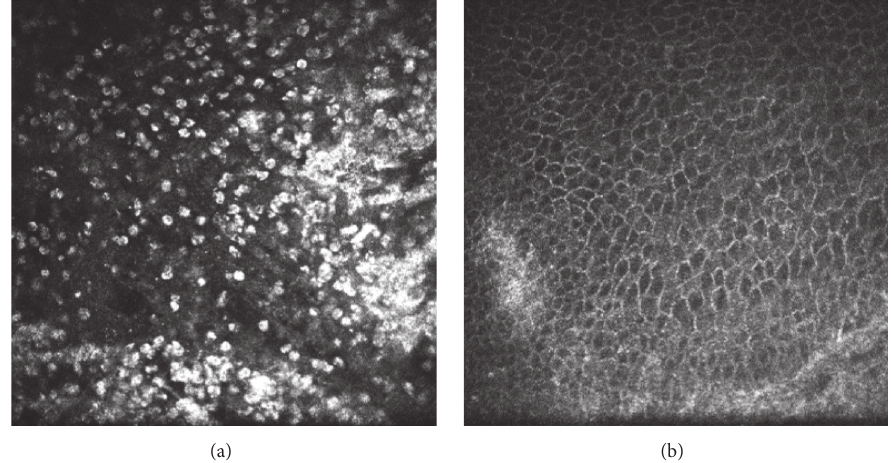
Figure 3: (a) Abundant inflammatory cells were displayed in the epithelium and basal membrane surrounding the epithelial nonhealing region of the ulcer. (b) The number of inflammatory cells decreased significantly at 2 months after surgery.